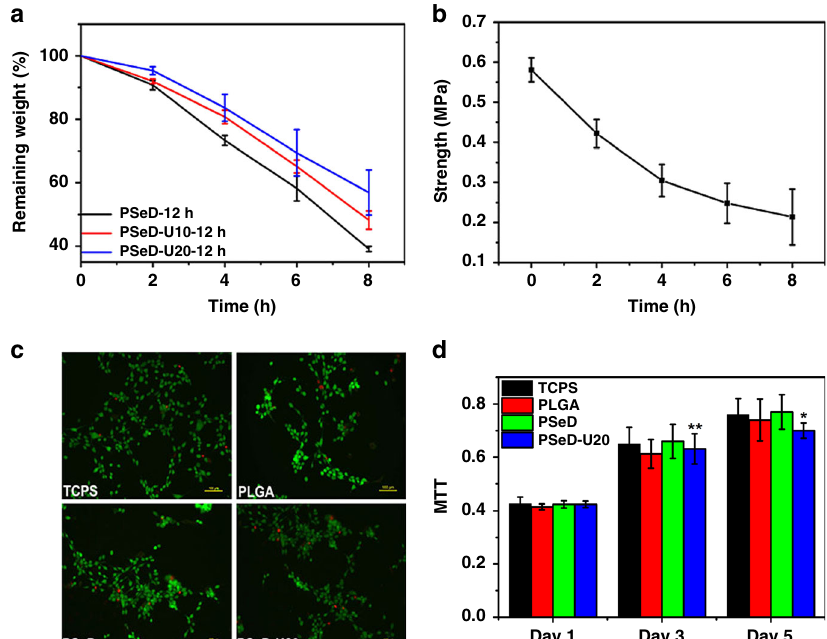
Fig. 3 The degradation behaviors and cytocompatibility of PSeD-U elastomers. a In vitro enzymatic degradation of PSeD and PSeD-U elastomers in lipase DPBS solutions (0.1 M) at 37 °C. b Tensile strength of PSeD-U20-12h at a strain of 200% after degradation for 0, 2, 4, 6, 8 h, showing a gradual decrease of mechanical strength. c Images of NIH 3T3 fi broblasts in live/dead assays of TCPS, PLGA, PSeD, and PSeD-U20. A large amount of live cells (green) and few dead cells (red) at all surface, indicating the good biocompatibility of PSeD-U (magni fi cation = ×100; scale bar = 100 μ m). d The MTT assay of NIH 3T3 fi broblasts cells cultured on TCPS, PLGA, PSeD, and PSeD-U20 elastomers. There was no signi fi cant difference between different materials at the same time point. Statistical signi fi cance compared with previous time point was marked as * p < 0.05 or ** p < 0.01.